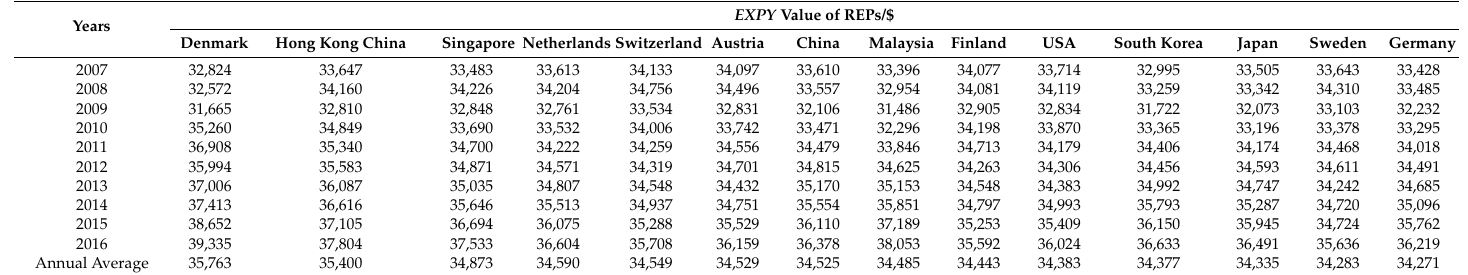
Table 4. Changes in overall export technical level ( EXPY ) values of REPs in 14 countries (or regions).